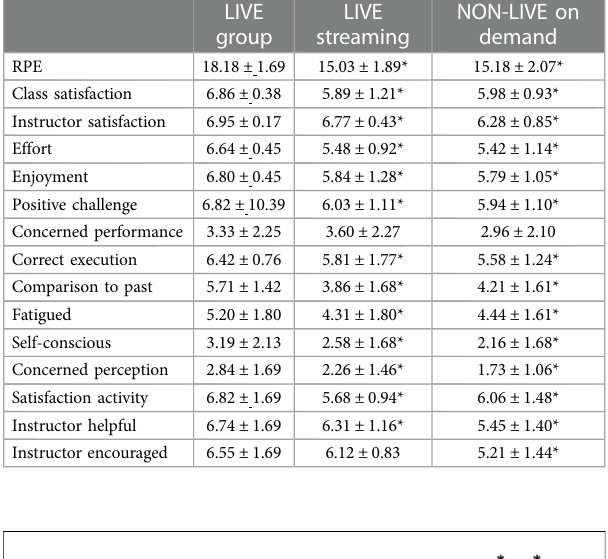
TABLE 1 Survey items gathered using a slider with a scale of 1 – 7 except for rate of perceived exertion (RPE) which was a scale from 6 to 20. An * equals a statistical difference with LIVE group (all values p